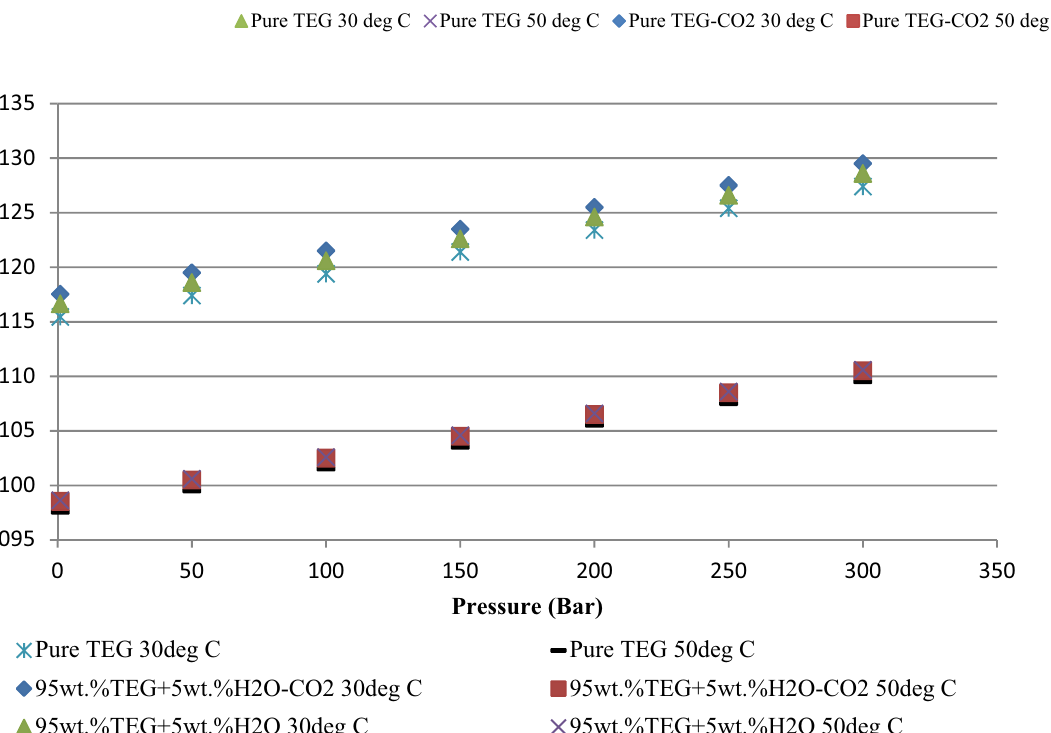
2 mixtures as a function of pressure at 30 °C and 50